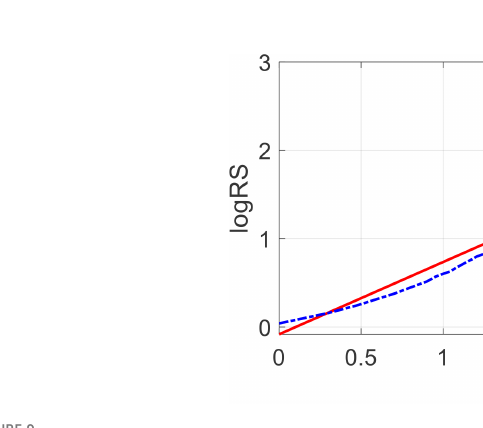
FIGURE 9 The fi tted regression lines of the Hurst exponent.